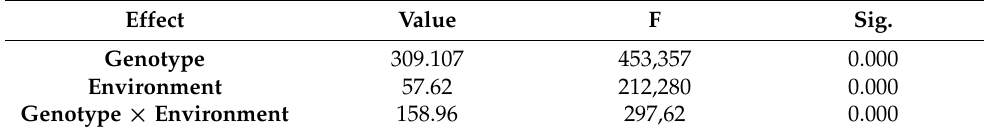
Table 1. Multivariate test from a general linear model for 61 olive cultivars in two crop seasons. The factors were significant, with values of p ≤